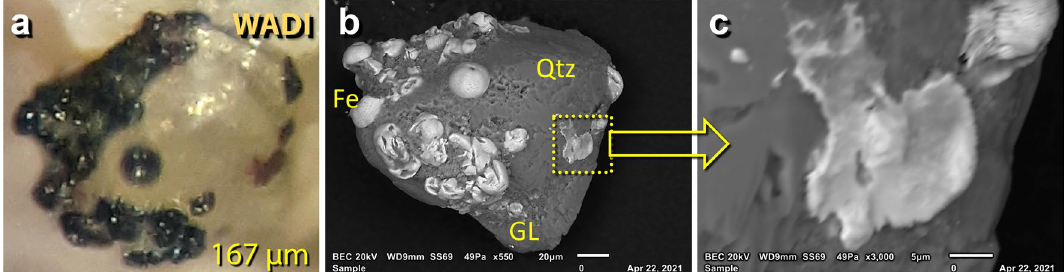
Figure 28. Fe-rich spherules embedded in meltglass. ( a ) Optical photomicrograph of a 167-µm-wide piece of meltglass with embedded Fe-rich spherules. ( b ) SEM image of same grain as in panel ‘ a ’. Melted quartz grain (Qtz) is embedded in Ca–Al–Si-rich matrix, which has the same composition as melted mudbrick. ( c ) SEM close-up image of the boxed area and panel ‘ b ’, showing splattered Fe-rich spherule.